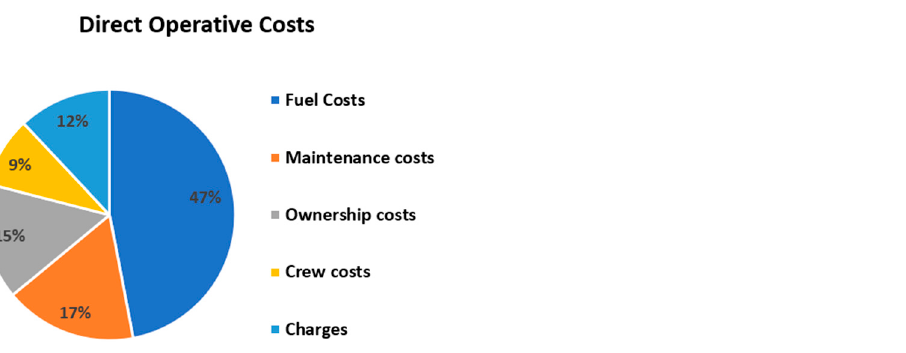
Figure 36. Typical cost breakdown for commercial aircraft according to International Air Transport Association (IATA) [157,158].